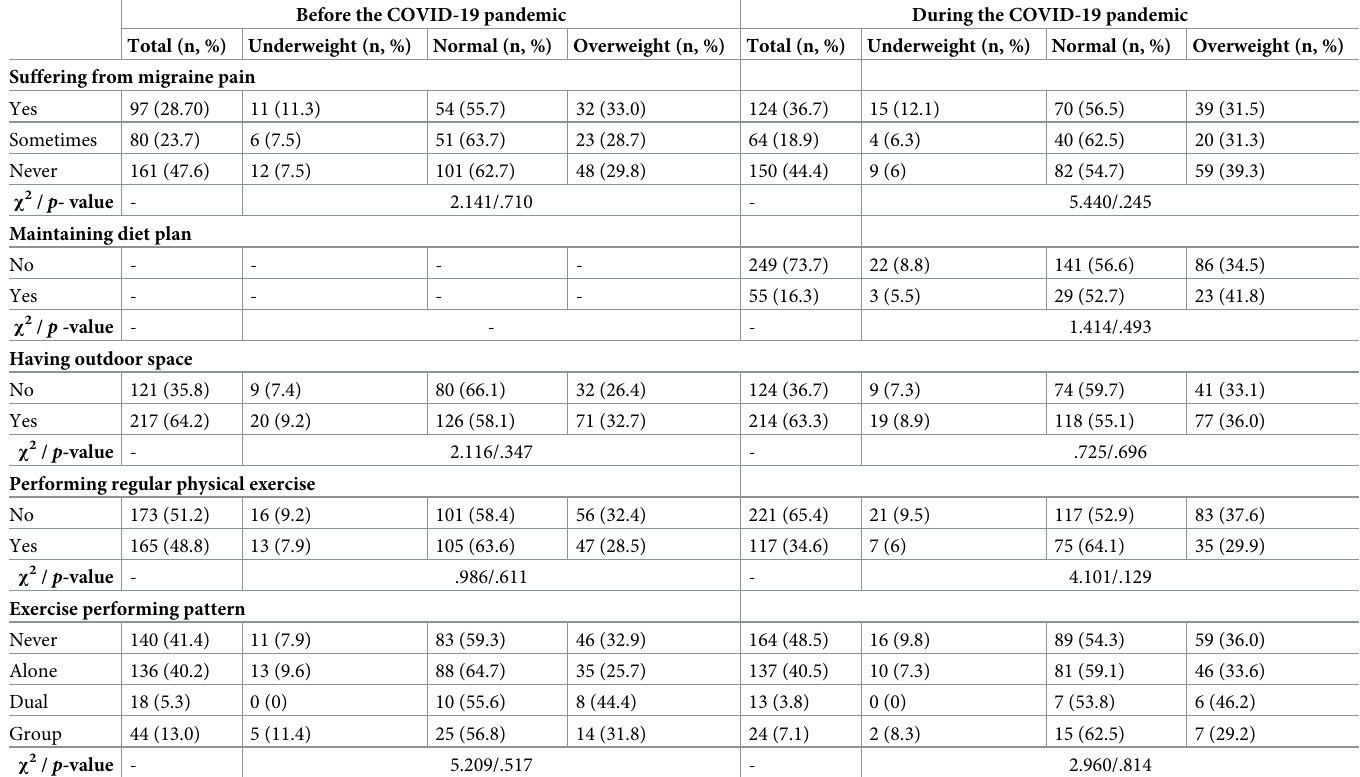
Table 2. Associations between physical activities -related variables and BMI status. Before the COVID-19